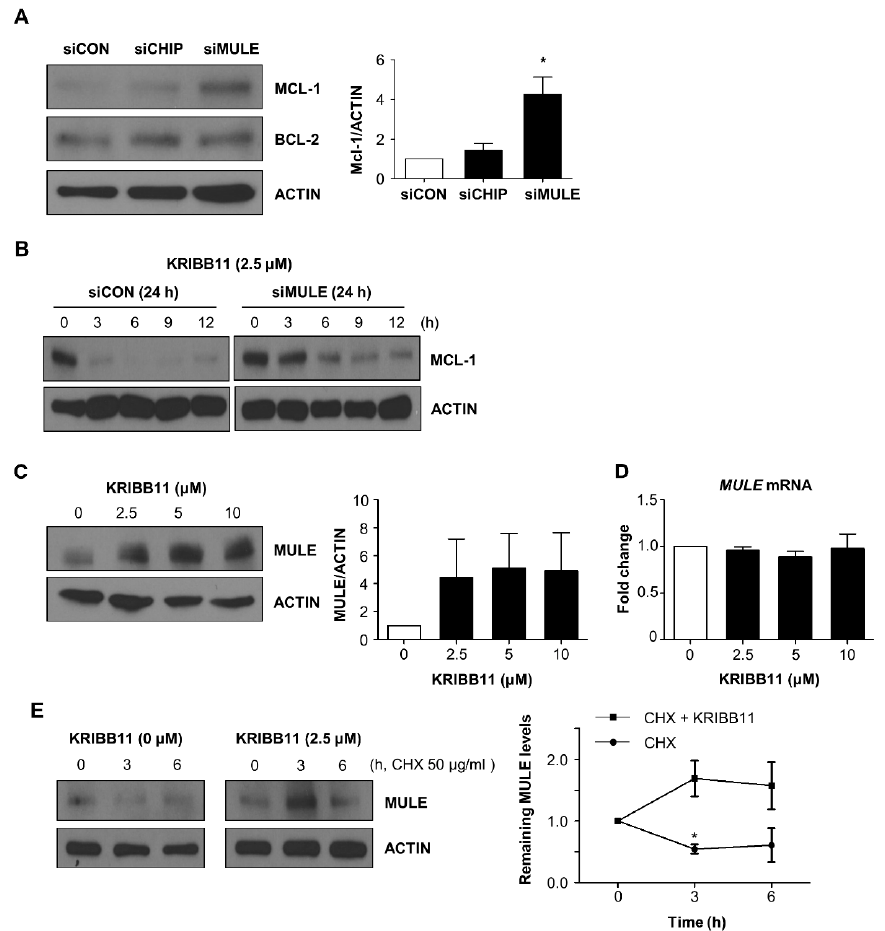
Figure 4. MCL-1 ubiquitin ligase MULE was stabilized by KRIBB11. ( A ) The effect of MULE depletion on MCL-1 was examined by transfection of specific siRNA (100 nM) for 48 h and subsequent Western blotting ( upper ). The relative levels of MCL-1 after depletion of CHIP or MULE were shown by densitometry analysis ( lower ). ( B ) MULE depletion retarded the KRIBB11-induced MCL-1 reduction, which was evaluated by Western blotting. ( C , D ). MULE levels after KRIBB11 treatment were determined by Western blotting ( C ) and qRT PCR analysis ( D ). ( E ) Cycloheximide (50 μ g/mL) was treated with KRIBB11 (2.5 μ M), and the kinetics of MULE expression was compared with cycloheximide only group by Western blotting ( left ). The quantitation of MULE was performed with densitometry ( right ). Data are mean ± SE of three independent experiments. * p < 0.05 vs. control values.